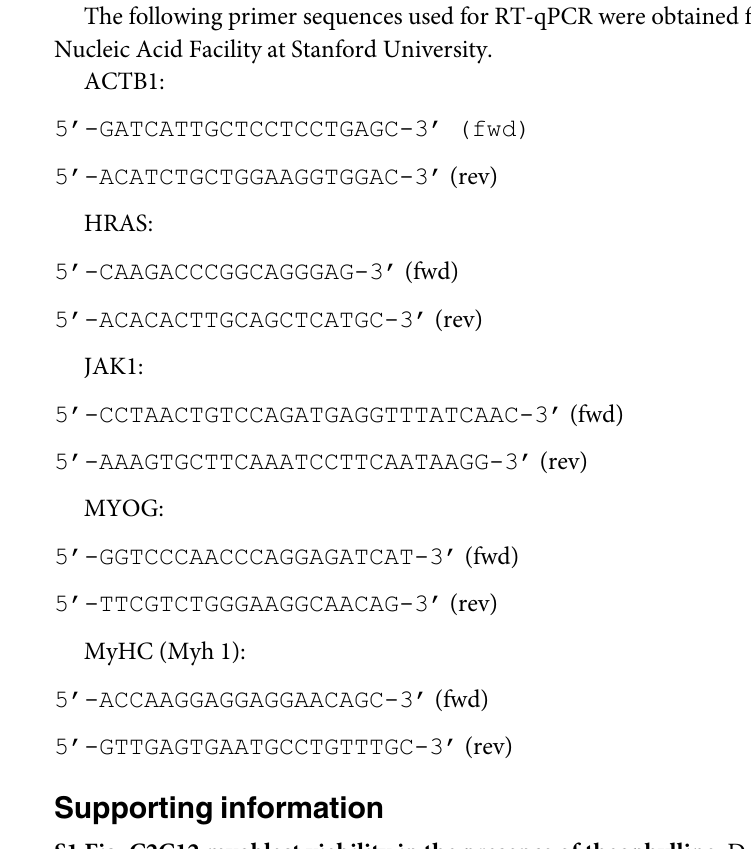
S1 Fig. C2C12 myoblast viability in the presence of theophylline. Dose response curve for C2C12 cell count showing relative cell count normalized to the cell count at 0 mM theophyl- line. Error bars indicate standard deviation of two biological replicates. S2 Fig. Comparison of sTRSV and sTRSVctrl constructs with WT. A. Real-time RT-qPCR detection of Myogenin five days after transient transfection of HRAS and JAK1 constructs compared to wild-type myoblasts. B. Real-time RT-qPCR detection of MyHC five days after transient transfection of HRAS and JAK1 constructs compared to wild-type myoblasts. Error bars indicate standard deviation of four biological replicates. S3 Fig. Theophylline-responsive ribozyme switches control HRAS expression in a dose- dependent manner. A. Dose response curve for TheoCAUAA ribozyme switch showing rela- tive HRAS mRNA transcript levels normalized to transcript levels at 1 mM theophylline. B. Dose response curve for TheoAGAAA ribozyme switch showing relative HRAS mRNA tran- script levels normalized to transcript levels at 1 mM theophylline. Error bars indicate standard deviation of three or more biological